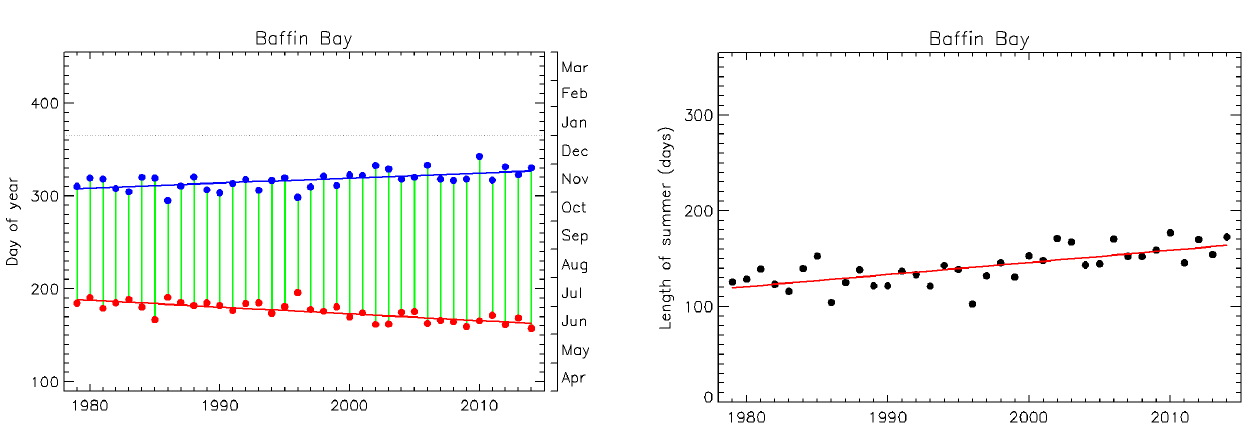
Figure 5. Length of the summer season (from spring sea-ice retreat to fall sea-ice advance) vs. year for Baffin Bay (all depths), with least-squares line in red (slope: + 12.7daysdecade − 1 ) . See Fig. S3 for similar plots for other regions.